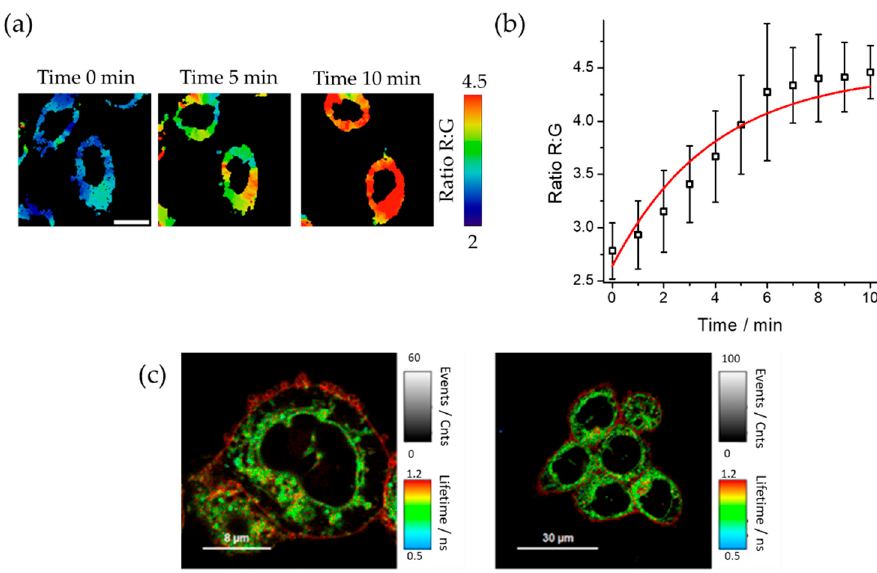
Figure 6. ( a ) Fluorescence microscopy R:G ratio maps of the live A-375 cell line at different time points after adding DCM-HBU obtained by two-photon excitation at 800 nm (G: 520/35, R: 685/70). Scale bar represents 10 µ m; ( b ) representation of the R:G ratios from microscopy images. Error bars represent the SD; and ( c ) FLIM of live A-375 cell line after adding DCM − NH 2 5 µ M by excitation with two 800 nm photons.